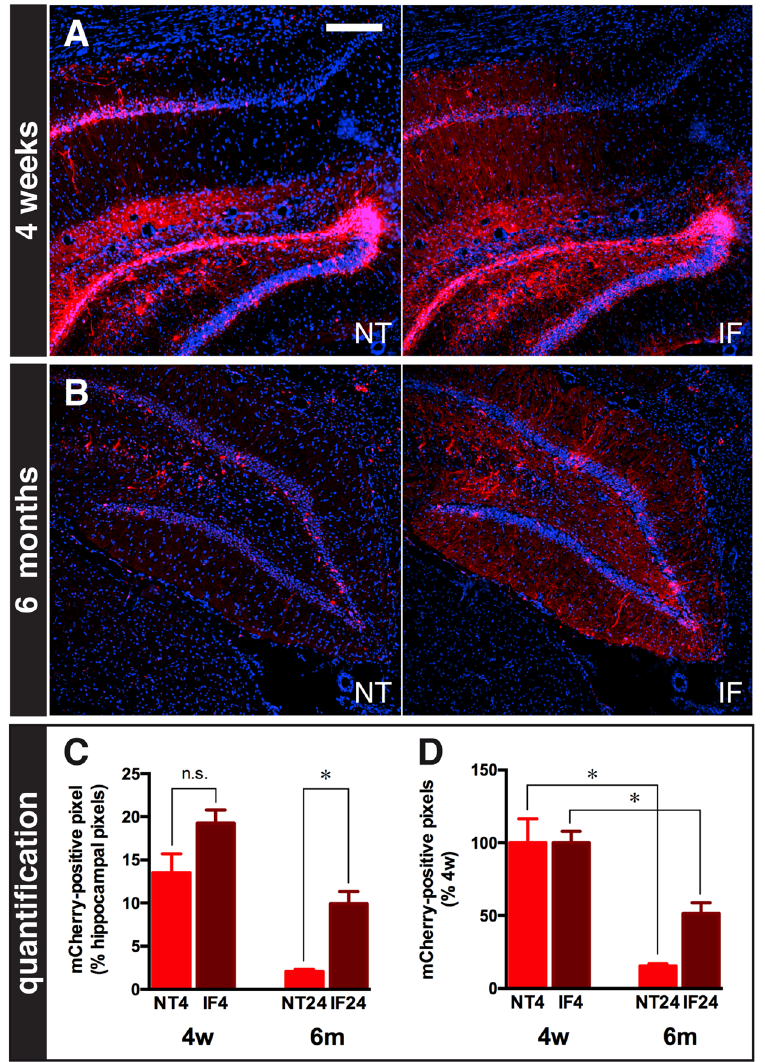
Figure 4. Comparison of native (NT) and immune-fluorescence (IF) mCherry signals. ( A , B ) Representative images (5 sections/animal, 4 animals/group) of coronal sections from animals killed 4 weeks ( A ) or 6 months ( B ) after J Δ NI6 injection. NT and IF signals, both in red, are shown for the same fields. Nuclei are stained in blue with DAPI. Size bar (all panels) = 100 μ m. ( C ) Quantification of NT (bright red) and IF (dark red) mCherry signals at 4 weeks (4 w) and 6 months (6 m). (D) Relative decay of NT (bright red) and IF (dark red) mCherry signals between 4 weeks (4 w) and 6 months (6 m). Data are the means ± s.e.m. of 4 animals per group. n.s., not significant; * P < 0.05, Mann-Whitney U